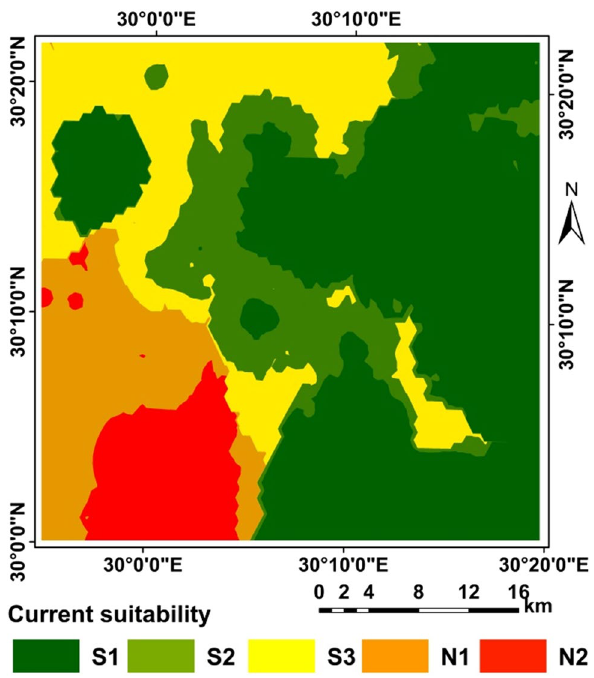
Figure 8. Current suitability based of the suggested